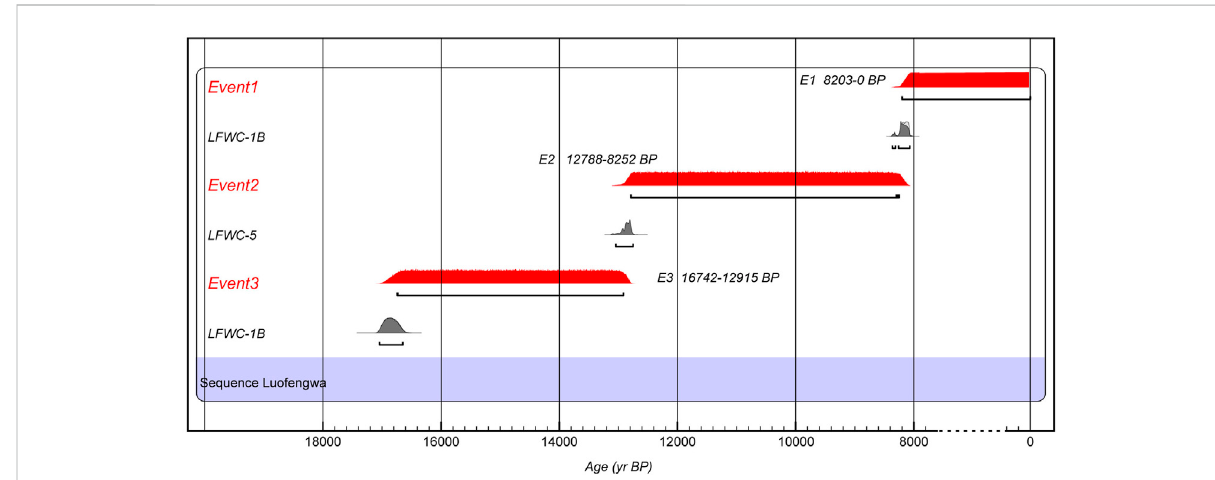
FIGURE 10 Results of OxCalanalysisof radiocarbon dates fromtheLuofengwatrenchingsite.Discordant samplesare not included. Un fi lled areasare prior probability distributions, and solid curves are posterior distributions after OxCal analysis. Phases are summed probability for units with multiple radiocarbon